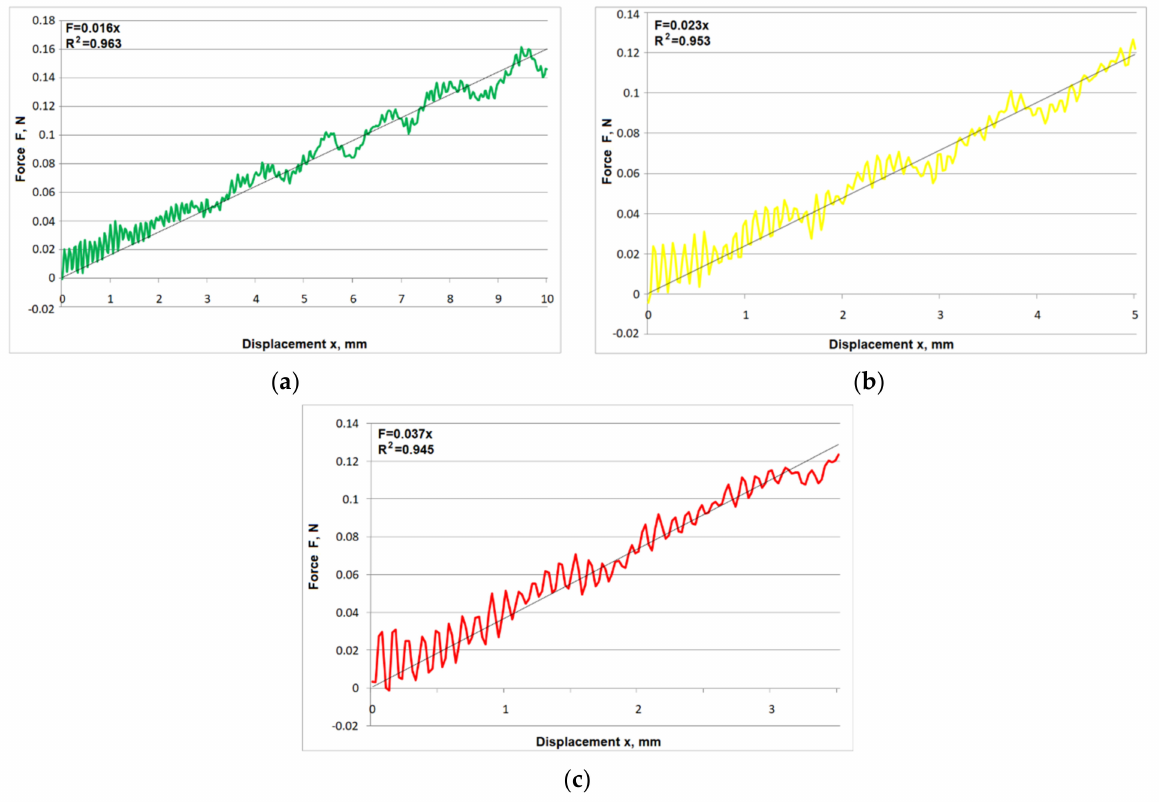
Figure 7. Examples of F(x) characteristics for a single cutting element with protrusion of: ( a ) L = L max ,